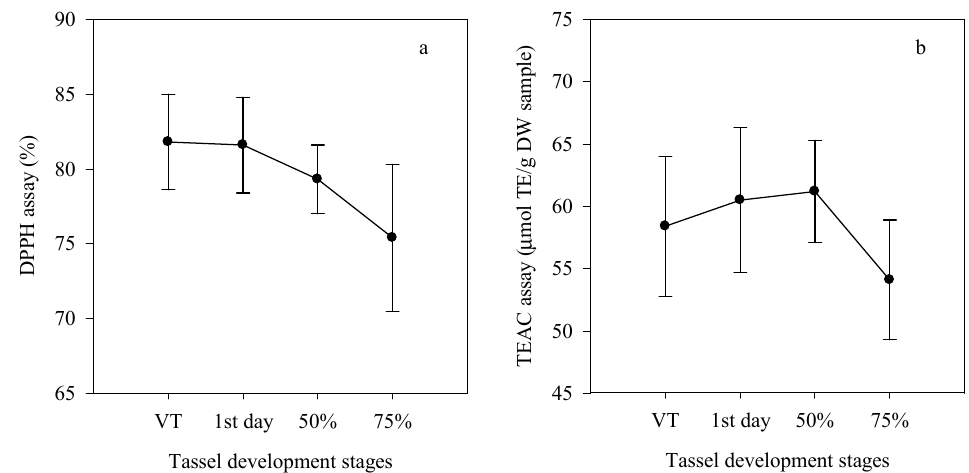
Figure 5. Effects of corn tassel development stages on the antioxidant capacity, as determined by 2,2 - diphenyl - 1 - picrylhydrazyl (DPPH) radical scavenging capacity assay ( a ) and Trolox equivalent antioxidant capacity (TEAC) radical scavenging capacity assay ( b ).